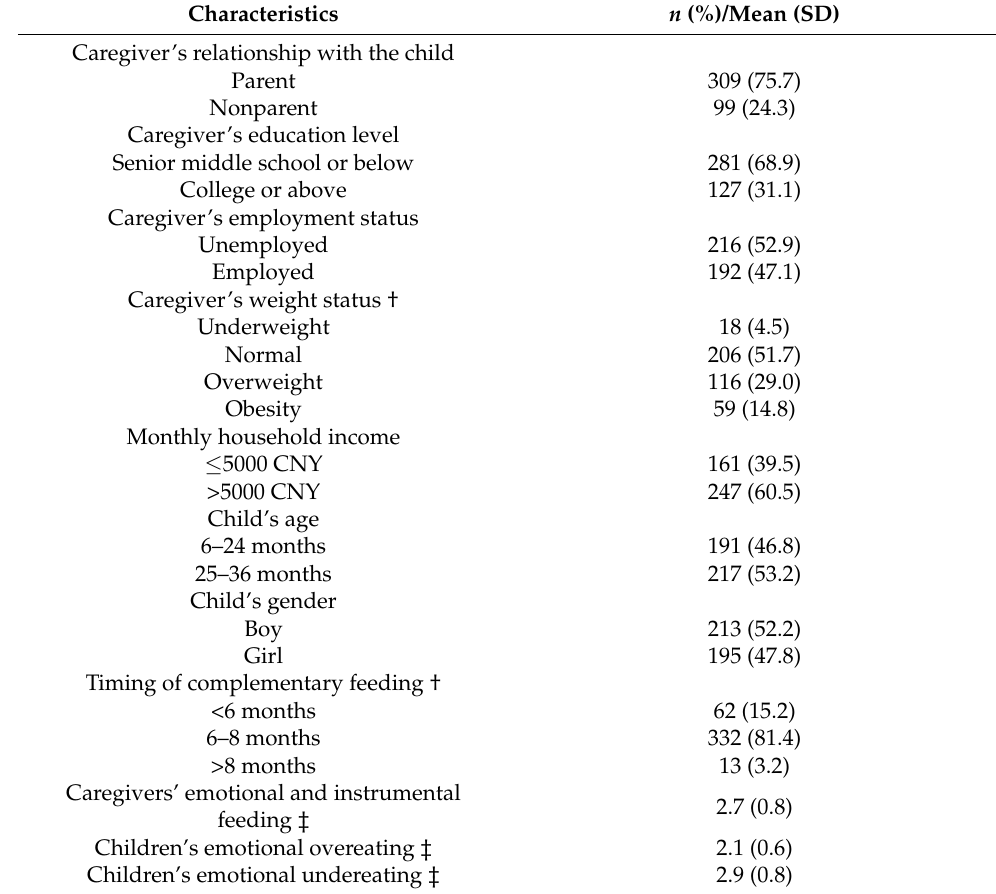
Table 1. Sociodemographic characteristics of the participants, caregivers’ feeding practices, and children’s emotional eating behaviours ( n = 408).